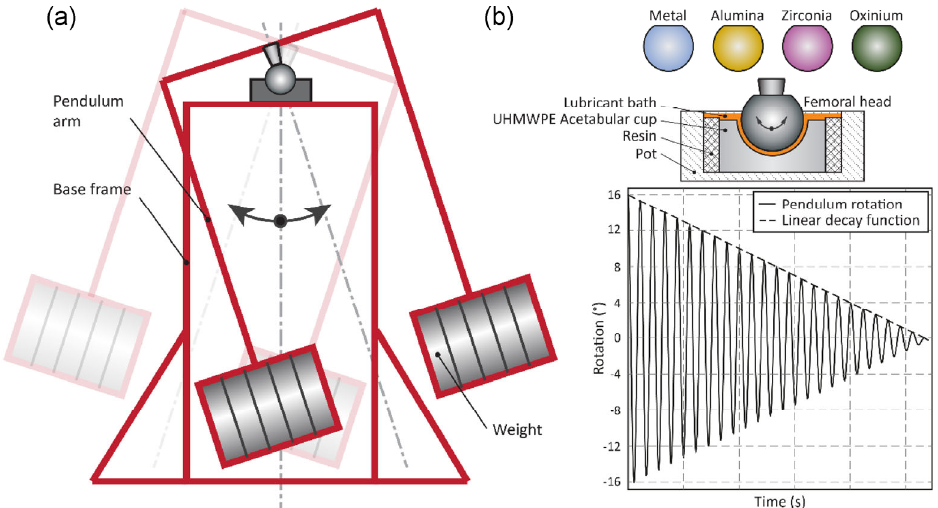
Fig. 1 (a) A schematic illustration of the pendulum hip joint simulator. (b) Overview of the tested femoral components, detail of the contact couple, and representative linear decay